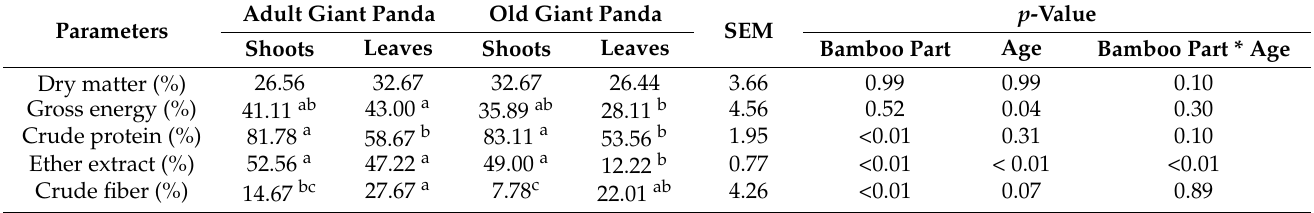
Table 1. Effects of bamboo part and age on apparent nutrient digestibility of captive giant pandas.